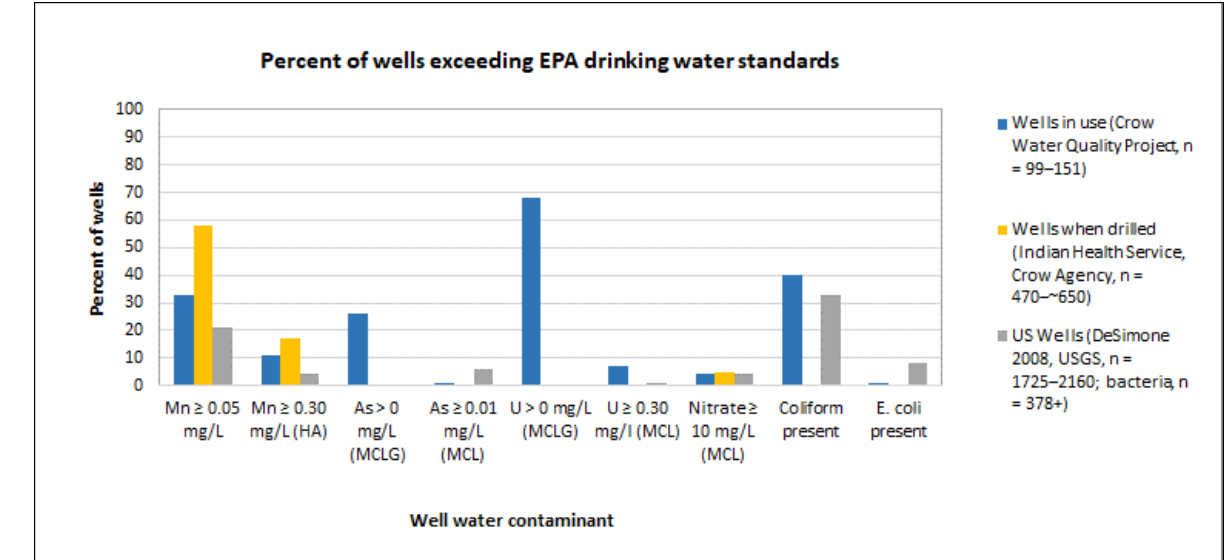
Figure 2. Percentages of home wells which exceed Environmental Protection Agency (EPA) drinking water standards for manganese (Mn), arsenic (As), uranium (U), nitrate, coliform, or Escherichia coli, comparing Crow Tribal home wells [23] with US Geological Survey (USGS) national data [19]. For manganese, 0.05 mg/L is the EPA secondary standard, and 0.30 mg/L is the Health Advisory. EPA MCLGs are Maximum Contaminant Level Goals and MCLs are Maximum Contaminant Levels for health. For nitrate, both the MCLG and the MCL are 10 mg/L [50]. The presence of coliform indicates risk of fecal contamination, while E. coli confirms it. “Wells when drilled” data courtesy of Indian Health Service Hospital, Crow Agency, MT. Absent values are “no data collected” [23].